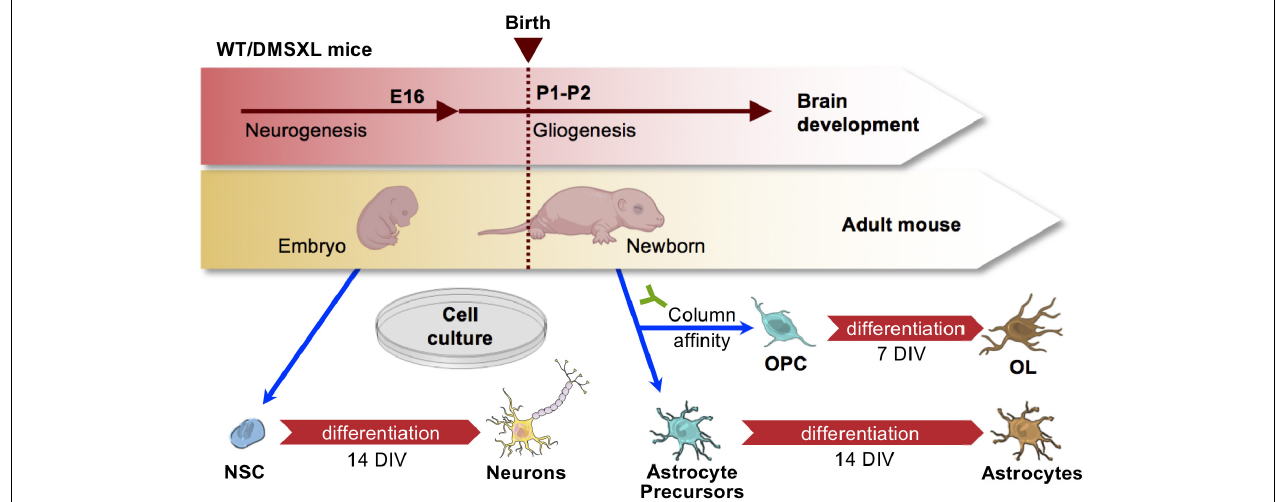
FIGURE 1 | Strategy for the purification of primary brain cells from mouse cortex. Schematic representation of brain cell isolation from embryos and newborns. Precursor NSC were isolated from embryos at E16, prior to gliogenesis onset, and subsequently differentiated for 14 days in vitro (DIV). Astrocytes and OPC were isolated at birth. Astrocytes were differentiated for 14 DIV, while OPC were differentiated into OL over 7 DIV. Drawings of mouse embryo and newborn created with BioRender.com. Drawings of mouse embryo and newborn created with BioRender.com. Drawings of brain cells from Servier Medical Art, licensed under a Creative Commons Attribution 3.0 Unported License (CC BY